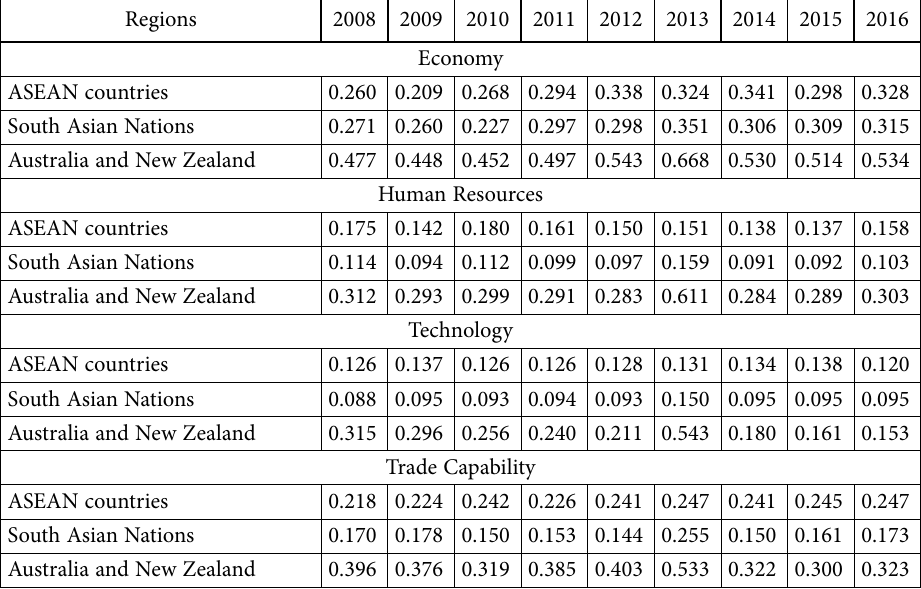
Table 5. Grey relational grades of the three regions